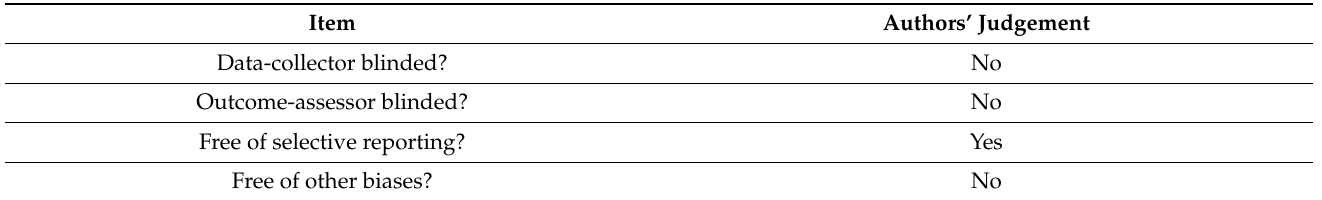
Table A24. Risk of